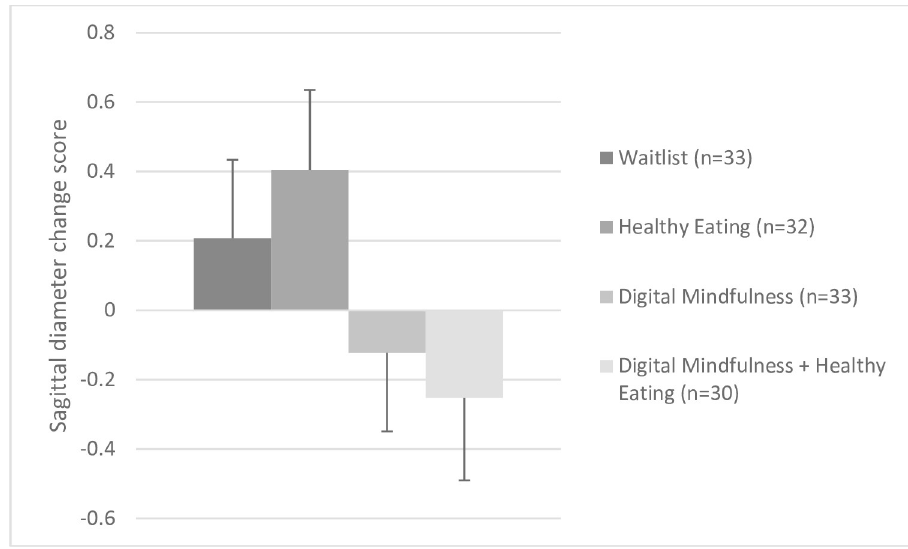
Fig 4. Effect of treatment randomization on sagittal diameter at 8 weeks, accounting for baseline